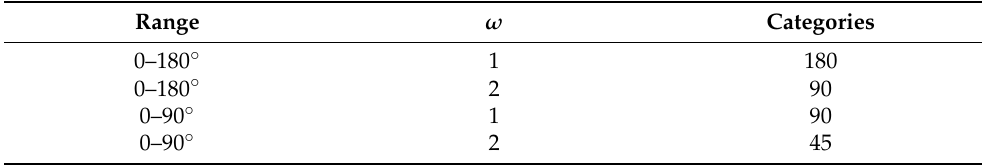
Table 1. The division of angle